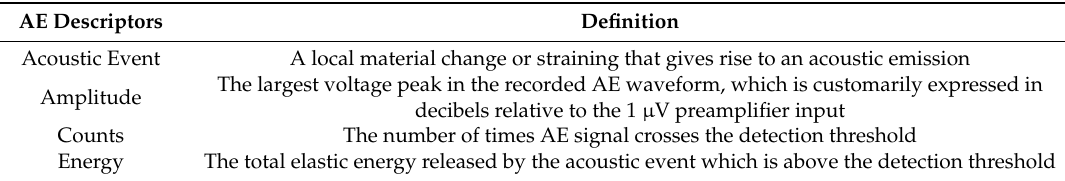
Table 1. Definitions of basic Acoustic Emission (AE) descriptors used for this research